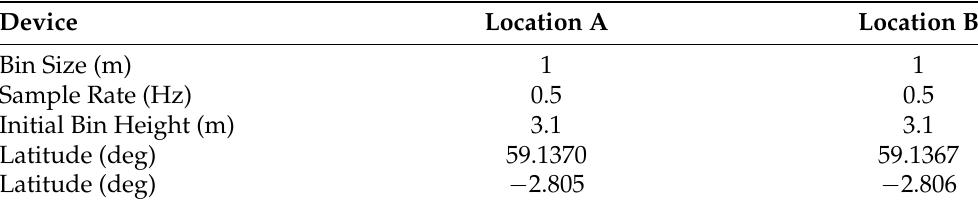
Table 1. Device information from the two RDI Workhorses used in the ReDAPT Project